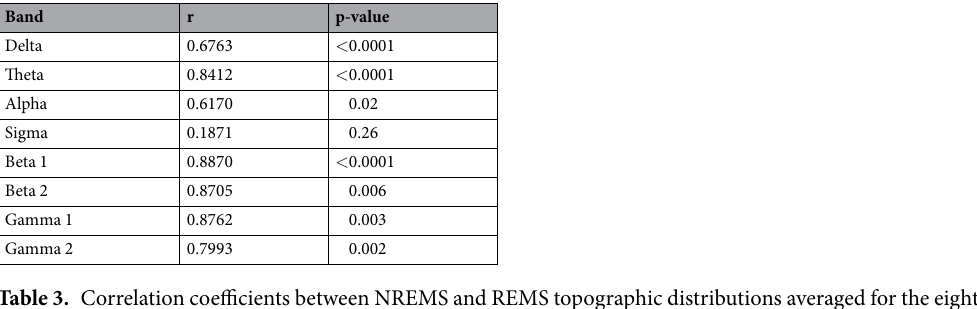
Table 3. Correlation coefficients between NREMS and REMS topographic distributions averaged for the eight frequency bands and the corresponding